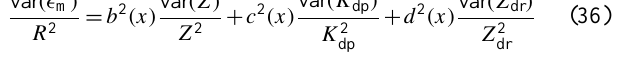
from simulated real-like data. Then σ((cid:15) p ) are computed us- ing simulated exact (only physically-based) data, and σ((cid:15) m ) are deduced